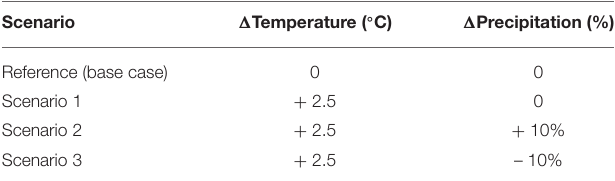
TABLE 1 | Synthetic climate change